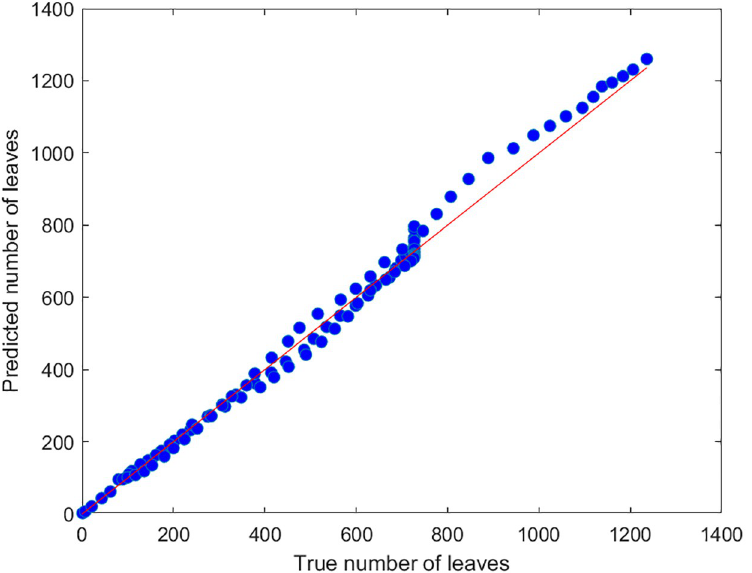
Fig 6. Prediction of number of leaves in test data. The number of leaves is predicted by a function fitting neural network with one hidden layer of 20 neurons. Inputs of the neural network include 13 predictors from the impulse response, including the total amplitudes, the number of peaks, as well as the (0, 10, ... , 100)% quantiles of the peak heights. The red line represents y = x .